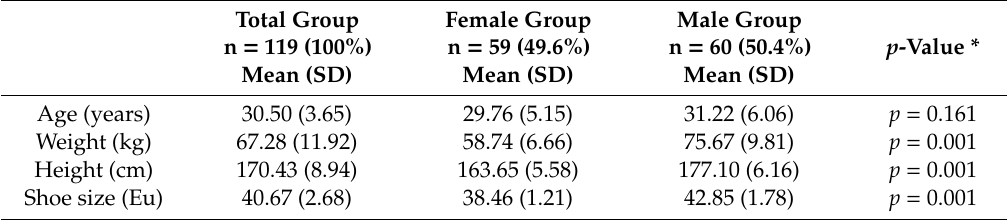
Table 1. Clinical characteristics of the sample